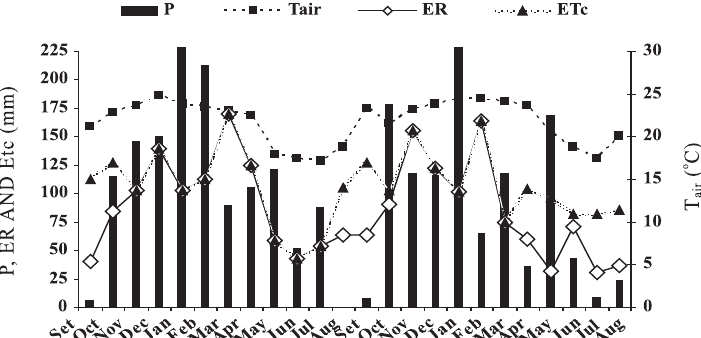
), actual evapotranspiration (ER), and potential crop air , T and T , at both 0 1 2